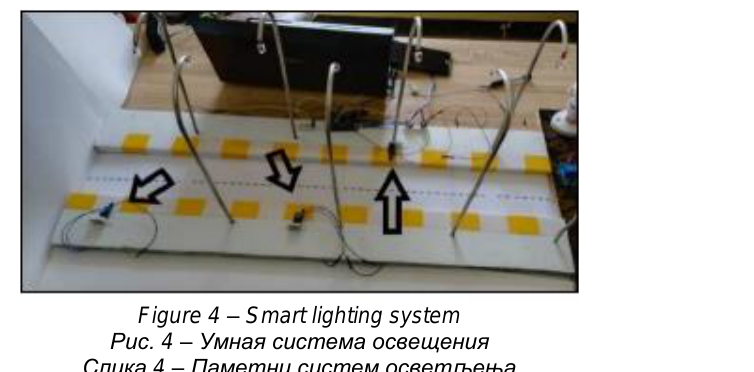
Figure 4 – Smart lighting